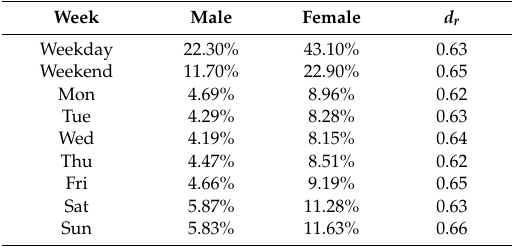
Figure 5. Number of check-in points for users of di ff erent genders within a week. Table 1. Gender di ff erences in weekday and weekend check-in numbers.